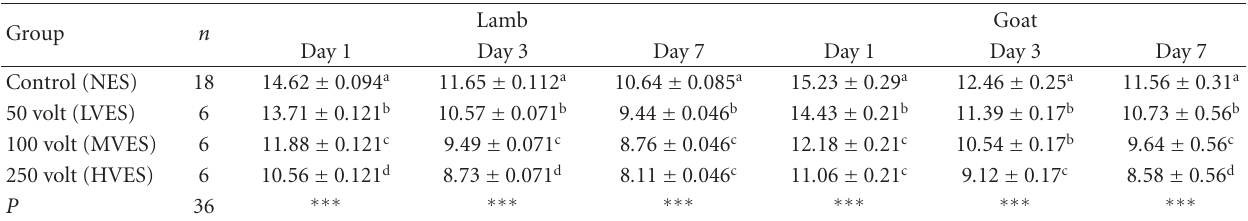
Table 5: Mean and standard errors of shear force values in lamb and goat meat during aging at 4 ◦ C (kg/cm 2 ). Lamb Group n